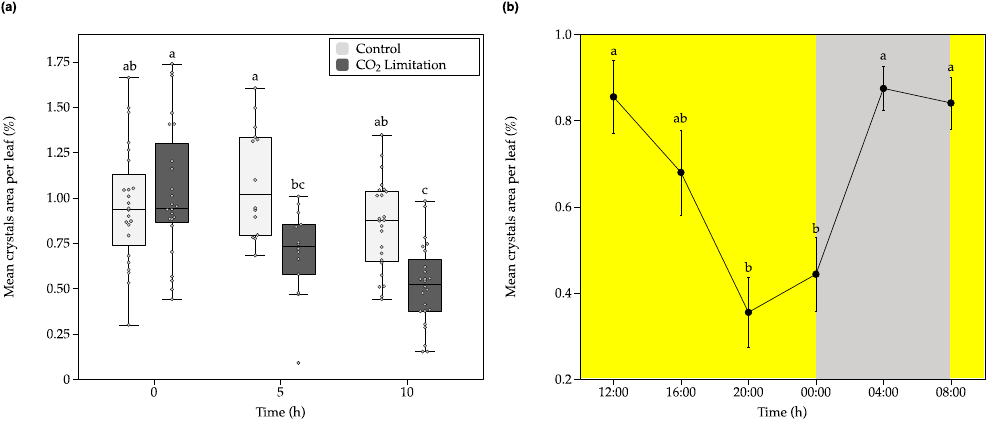
Figure 1. Fluctuations in total mean crystals area per leaf of C. quitensis plants under ambient or low CO 2 concentration. ( a ), Boxplots representing the effect of the CO 2 limitation treatment on leaf crystals area per leaf (%). The horizontal line indicates the mean and length of each whisker indicates the interquartile range (IQR); n = 14, different letters represent statistically significant differences (Two ‐ way ANOVA; p < 0.05). In ( a ), plants were kept over time under constant light in airtight chambers injected either with ambient air (Control, 400 ppm CO 2 , white boxes) or filtered air with soda lime (CO 2 limitation, 11.5 ppm CO 2 , gray boxes). ( b ), Diurnal fluctuations in CaOx crystal area in C. quitensis leaves. Plants were grown under optimal growth conditions. Yellow background denotes light hours, while gray background dark hours. Error bars denote SE of mean; n = 15. Different letters represent statistically significant differences between time of the day (one ‐ way ANOVA; p < 0.05).